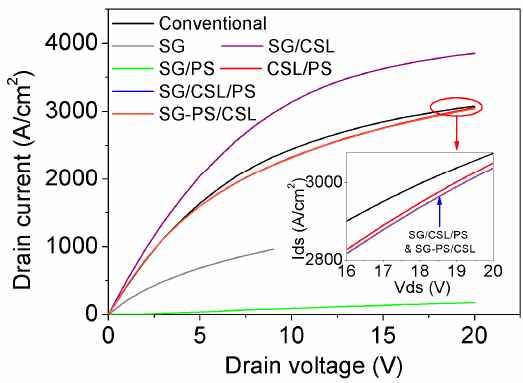
Figure 2. The on-state characteristics of different gate designs at Vgs = 20 V. The R ON,SP of the proposed SG/CSL/PS structure is 2.33 m Ω -cm 2 . © (2020) IEEE. Reproduced, with permission, from [14].